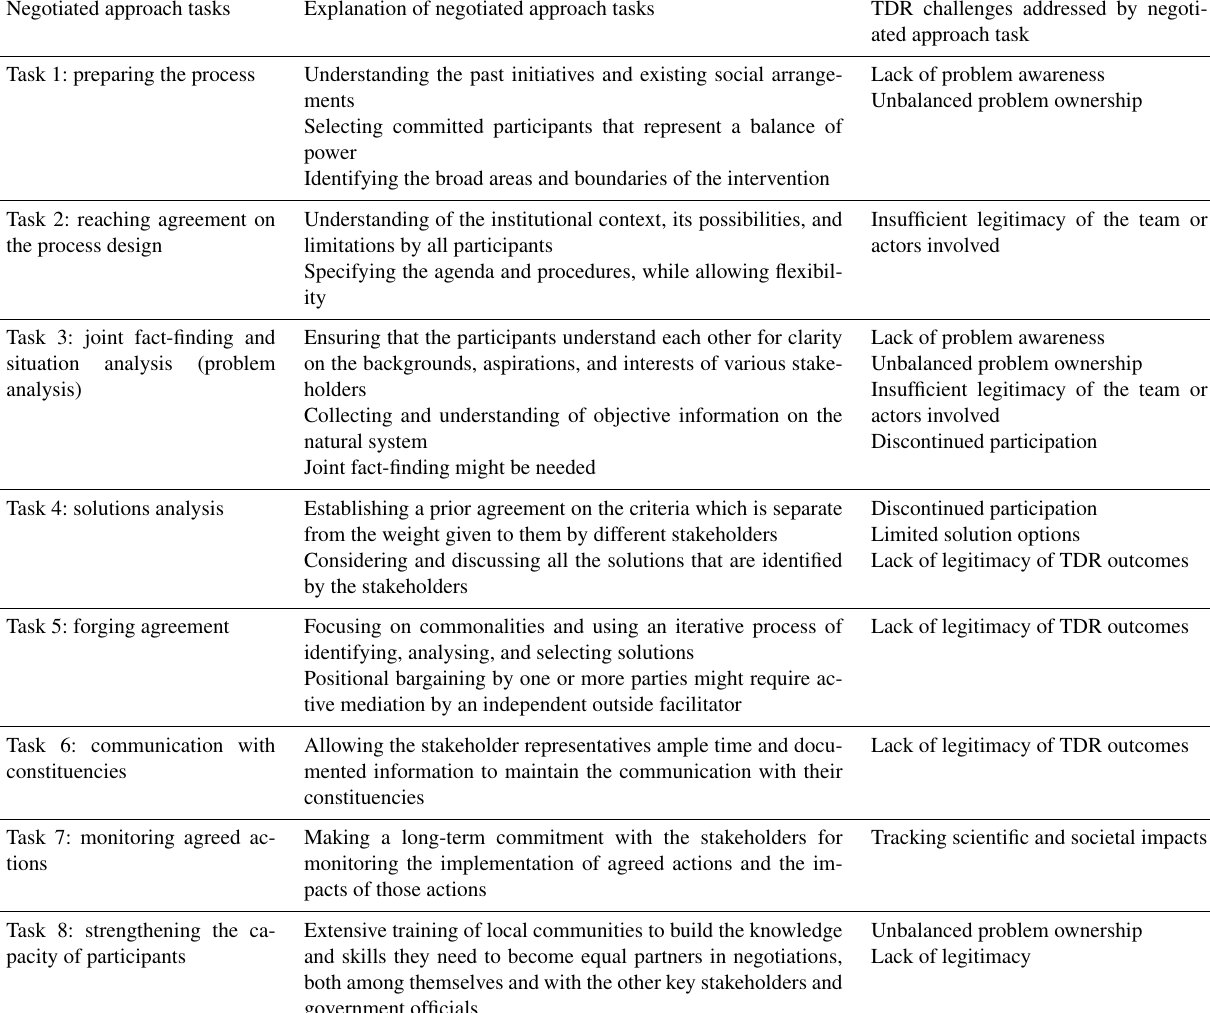
Table 2. Activities for the negotiated approach (Koudstaal and Paranjpye, 2011) and how they could help address some known challenges in transdisciplinary research